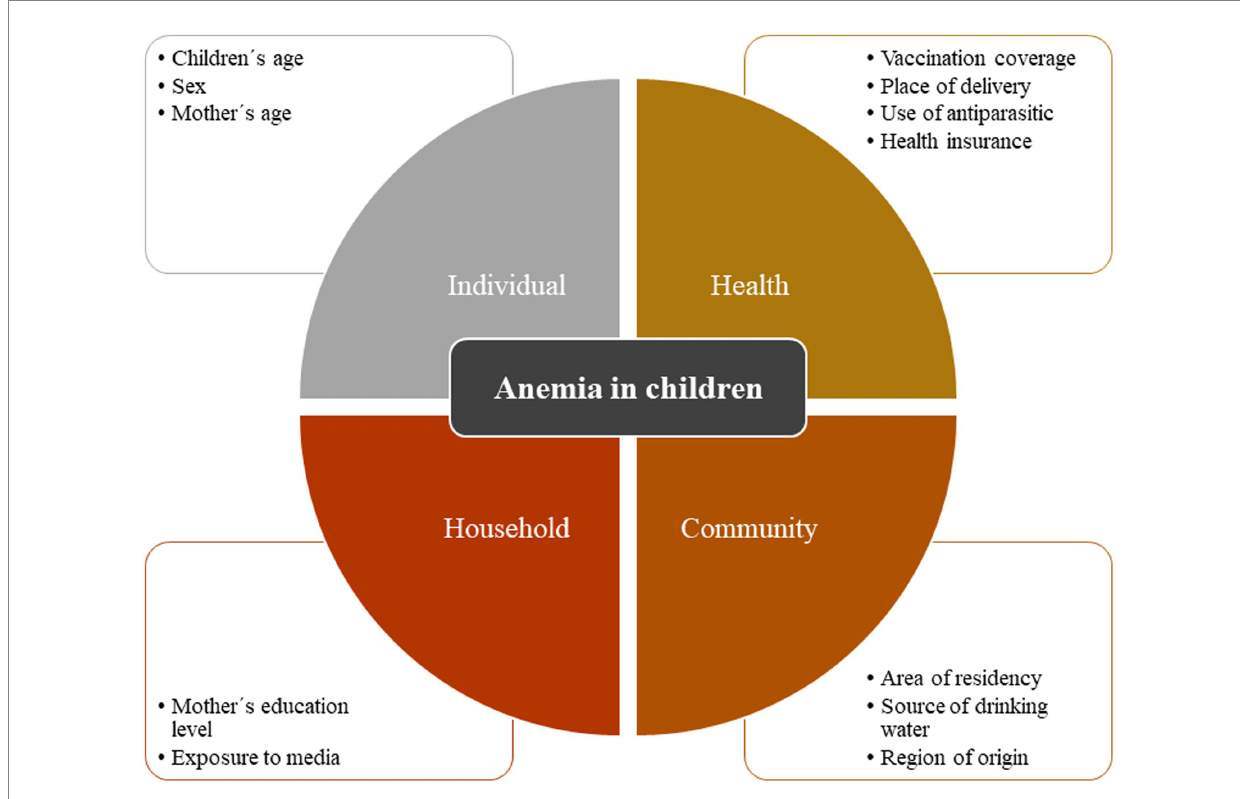
FIGURE 1 Framework of anemia in children *Adaptation based on the framework by Ngnie-Teta et al.